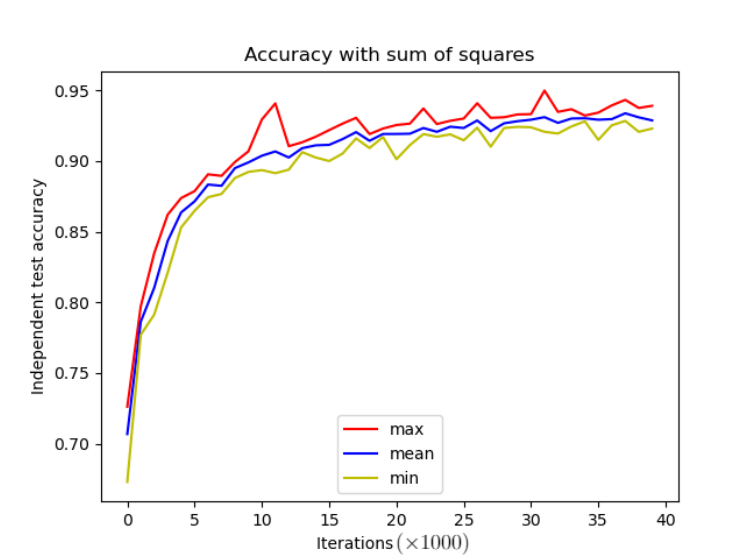
Figure 4. Five training results of MNIST classification in frequency domain with the proposed nonlinear activation function, with square sum instead of inverse FFT. The red color means the maximum accuracy, the blue line shows the mean accuracy and the yellow color is the minimum accuracy.